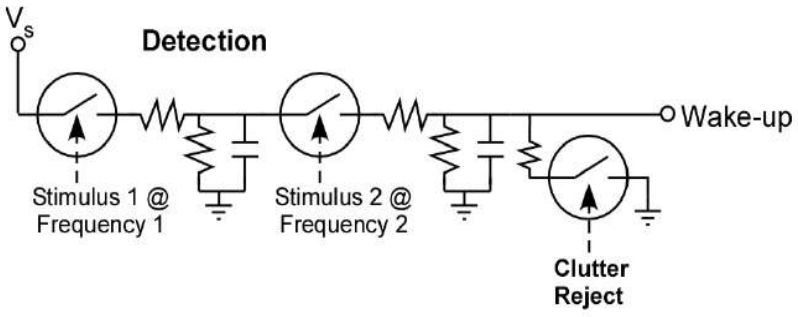
Figure 19. Acoustic wake-up microchip in Architecture 2 [28].